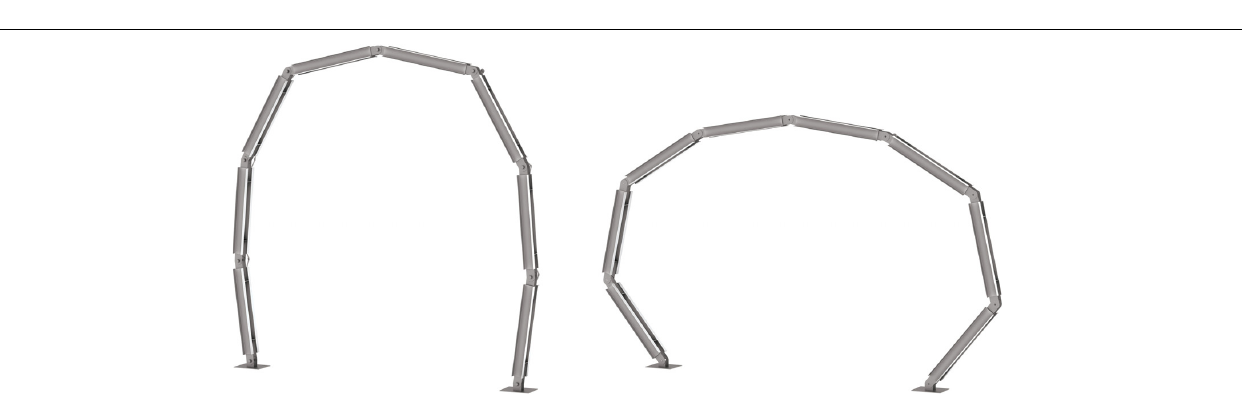
FIGURE 1 | The effective 4-bar concept for the 9-bar linkage ( N : locked joint, (cid:12) : unlocked joint, and (cid:52) : pivoted–to–the-ground joint) applied at a transformation step between the initial and target positions of the systems; (A) n -bar linkage; (B) effective 4-bar; and (C) initial system configuration of base actuation.